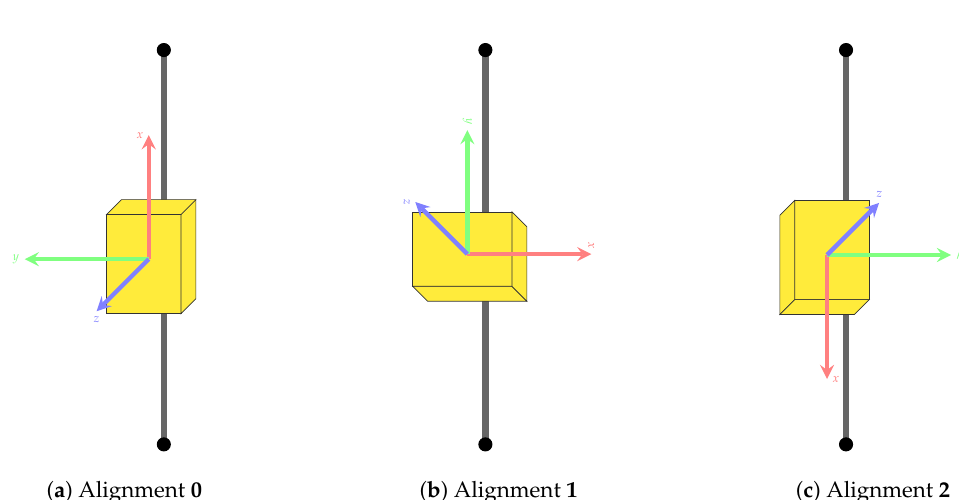
Figure A1. IMU alignments used during the recording of dataset B .